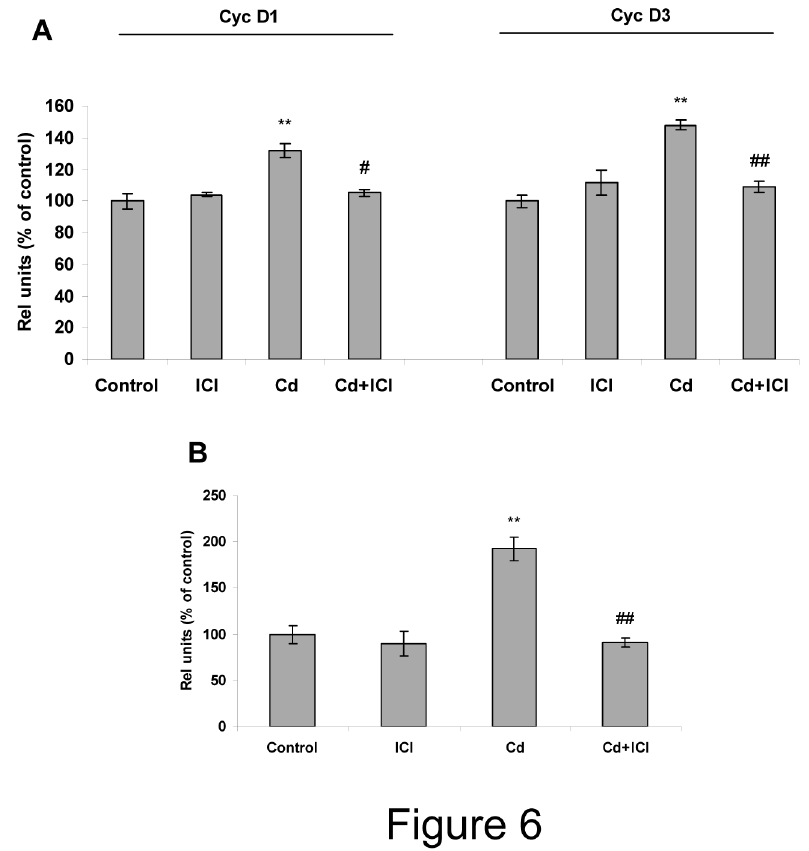
Figure 6. E2 receptors (ERs) mediates cadmium effect on cyclins D1 and D3 and PRL mRNA expression. Anterior pituitary cells cultures were first incubated with 100 nM ICI 182,780 (ICI) for 20 min and then incubated with vehicle (control) or 10 nM Cd for 72 h. Cyc D1 and D3 (A) and PRL (B) mRNA expression was evaluated by PCR. Bars represent the mean ± SE of densitometric values normalized to GAPDH and are expressed as percent of control. ANOVA followed by Tukey-Kramer’s test, **p<0.01 vs. control, ##p<0.01 vs. Cd (N=3).